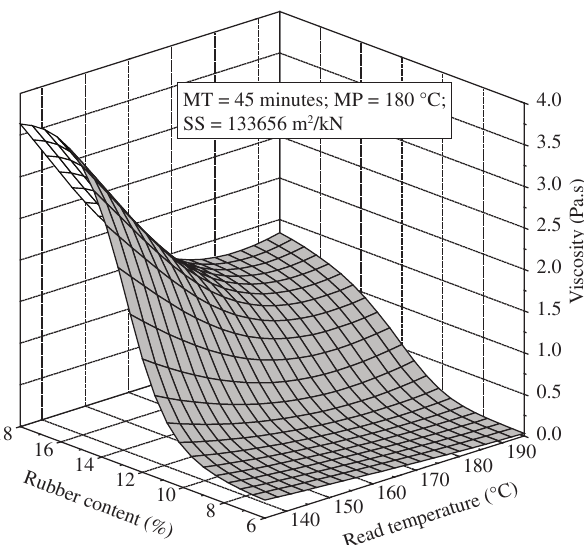
Figure 6. Surface η x RC x RT to neural network approach.